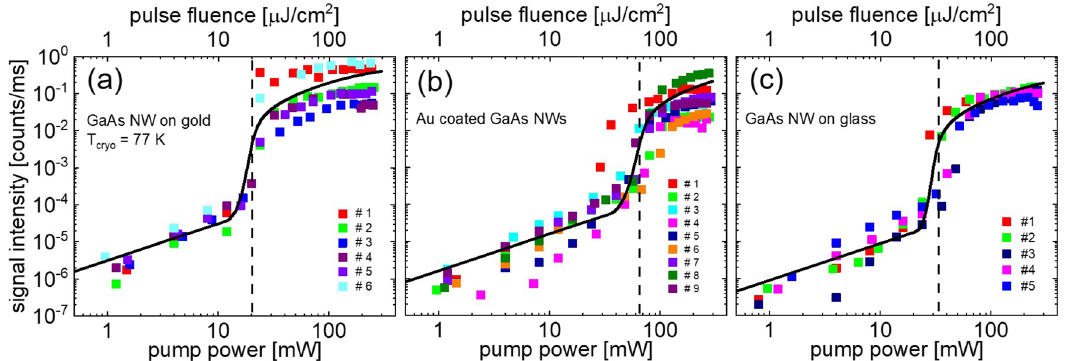
Figure 4. Peak power of the NW emission versus pump power ( L – L plot) obtained from lasing spectra of ( a ) NWs on Au film, ( b ) Au-coated NWs and ( c ) NWs on glass at T cryo = 77 K. Different colored symbols indicate NWs with different dimensions, which are summarized in tables ST1 to ST3. The thick black line shows calculated L – L curves of “average” NWs defined in table ST7. The vertical dashed lines indicate the approximate threshold power necessary for